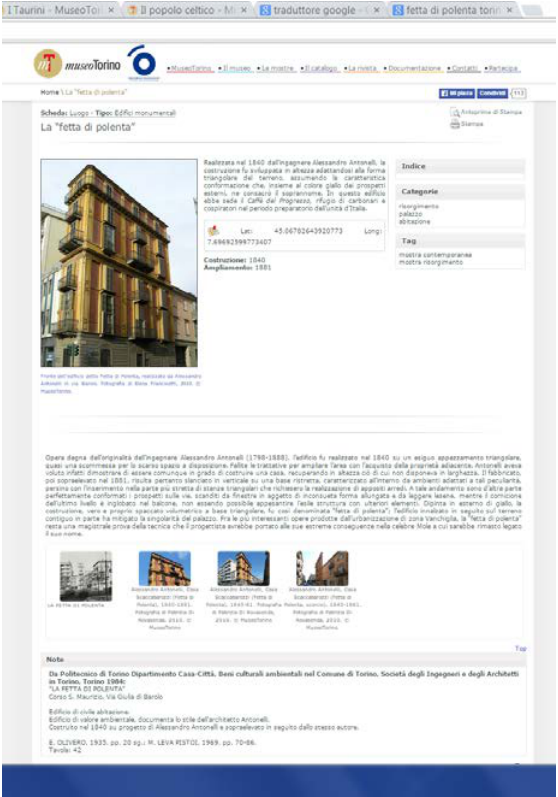
Figure 11. The description of the “Fetta di Polenta” and the link to main historical sources (e.g. books, pictures, drawings,